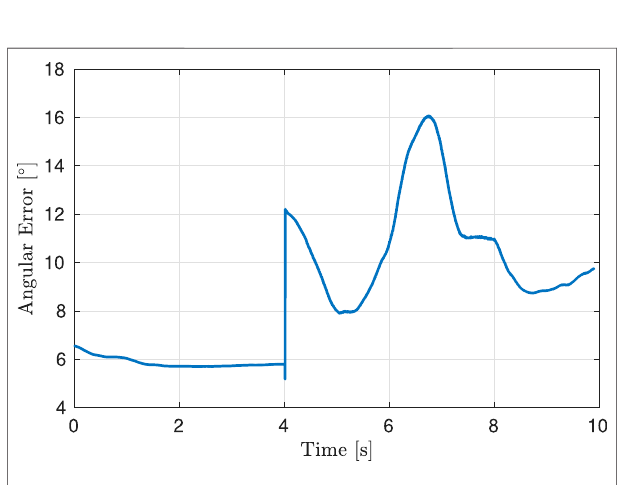
Frontiers in Robotics and AI |